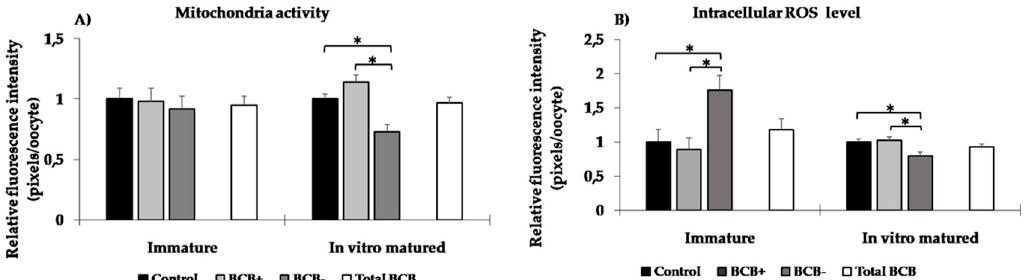
Figure 2. Mitochondria activity ( A ) and intracellular reactive oxygen species (ROS) level ( B ) in domestic cat oocytes immediately after Brilliant Cresyl Blue (BCB) staining and after in vitro maturation. Values are expressed as mean ± standard error of the mean (SEM). Immature: germinal vesicle; in vitro matured: metaphase II; total BCB: BCB + plus BCB − . Total BCB group was compared to control group. Symbol * indicate significant difference ( p < 0.05).